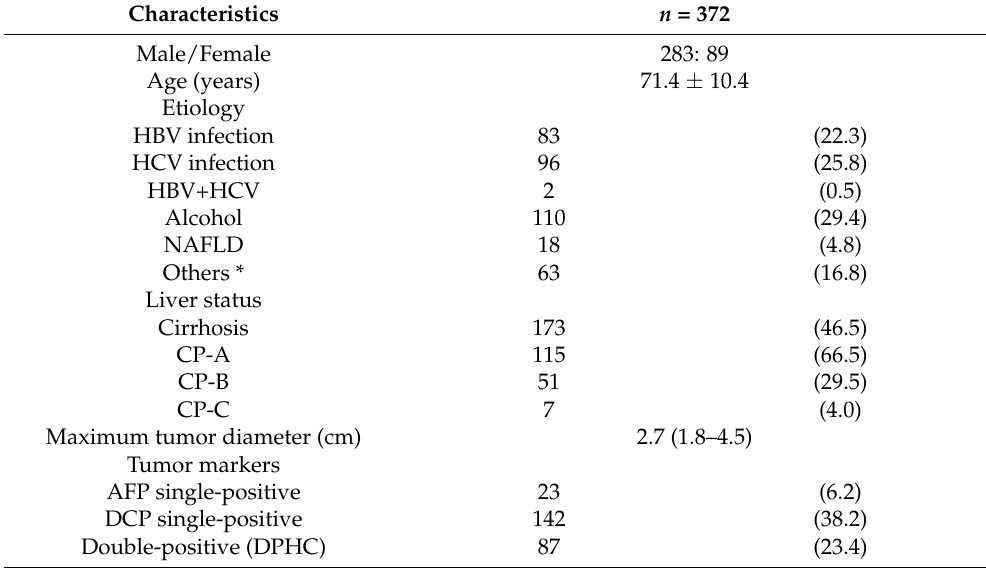
Table 2. Comparison between patients with DNHC and other groups.